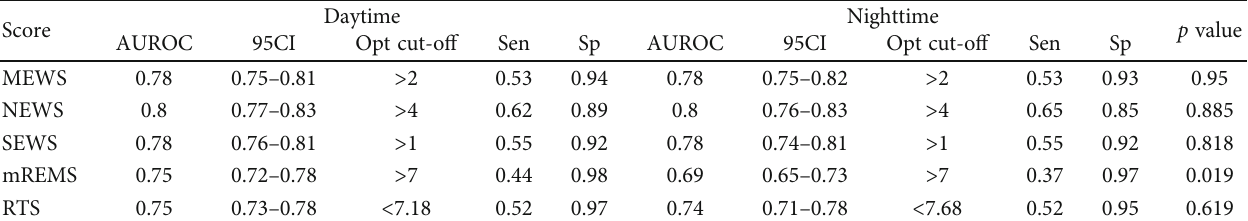
Figure 3: ROC curves for identifying severe trauma in patients with multiple trauma admitted during daytime and nighttime for fi ve triage scores. Table 5: Comparison of AUROCs, optimal cut-o ff s, sensitivity, and speci fi city for identifying severe